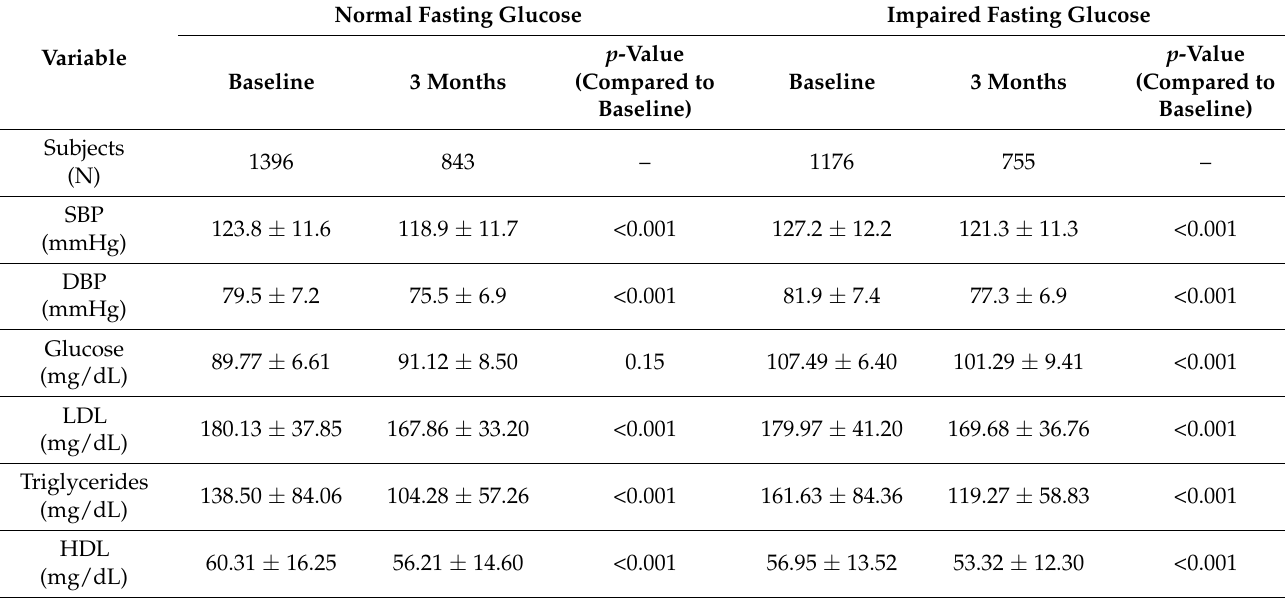
Table 2. Blood glucose and lipid